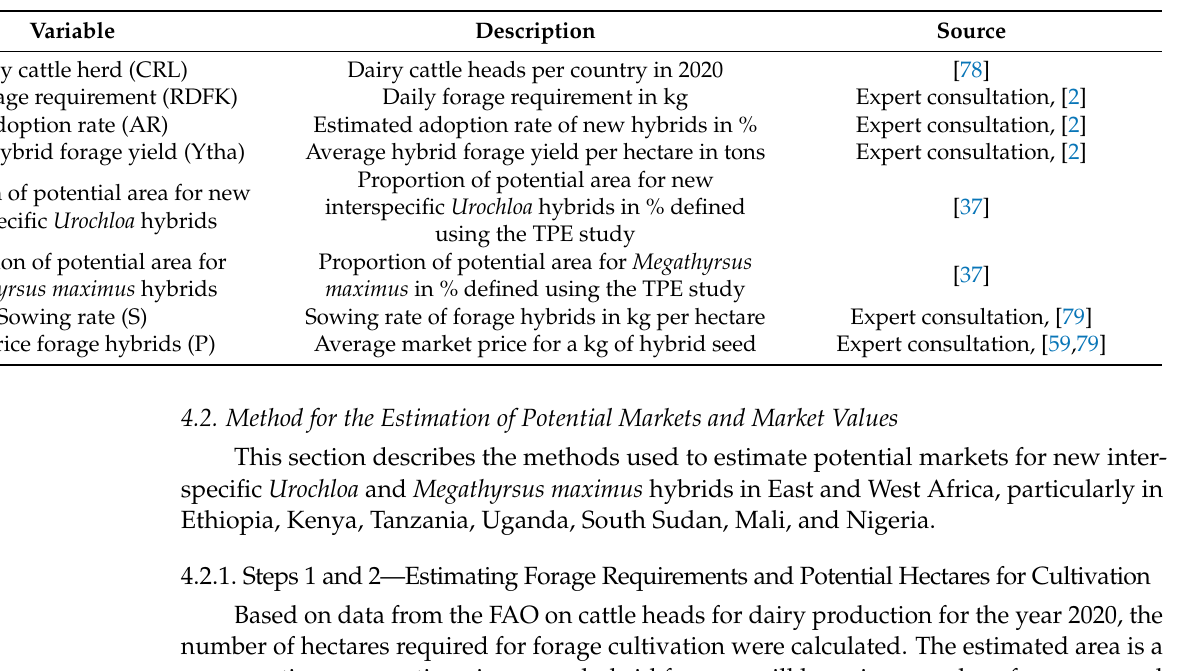
Table 3. Variables and information